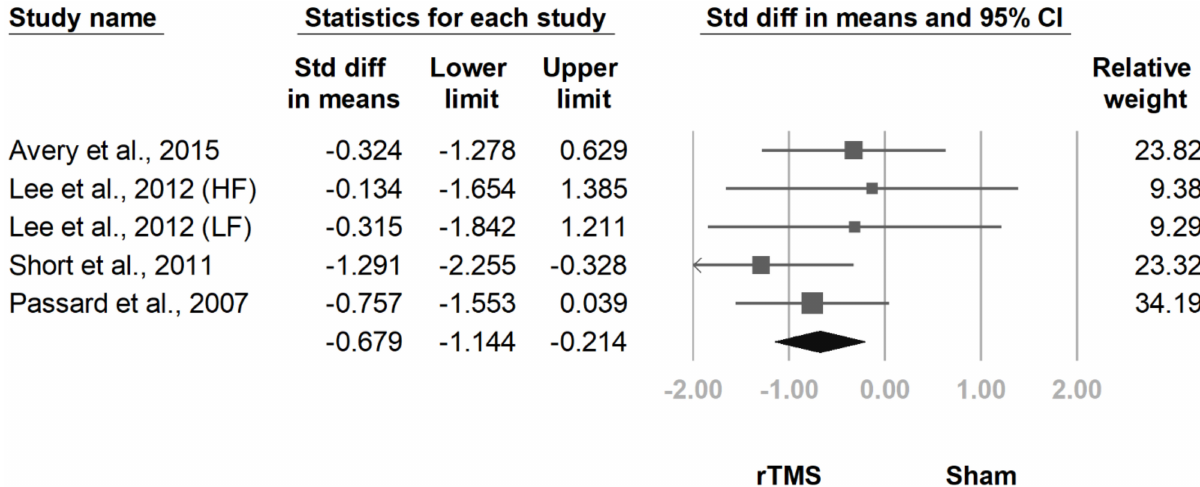
Figure 13. Forest plot of standardized mean differences in number of tender points after treatment. Squares indicate effect sizes of individual studies, lines indicate 95% CI, and diamond indicates the summarized effect size.